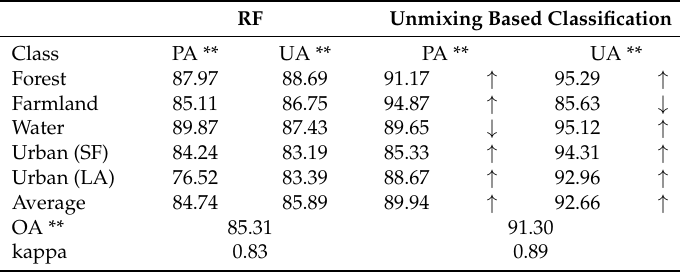
Table 2. Classification accuracy